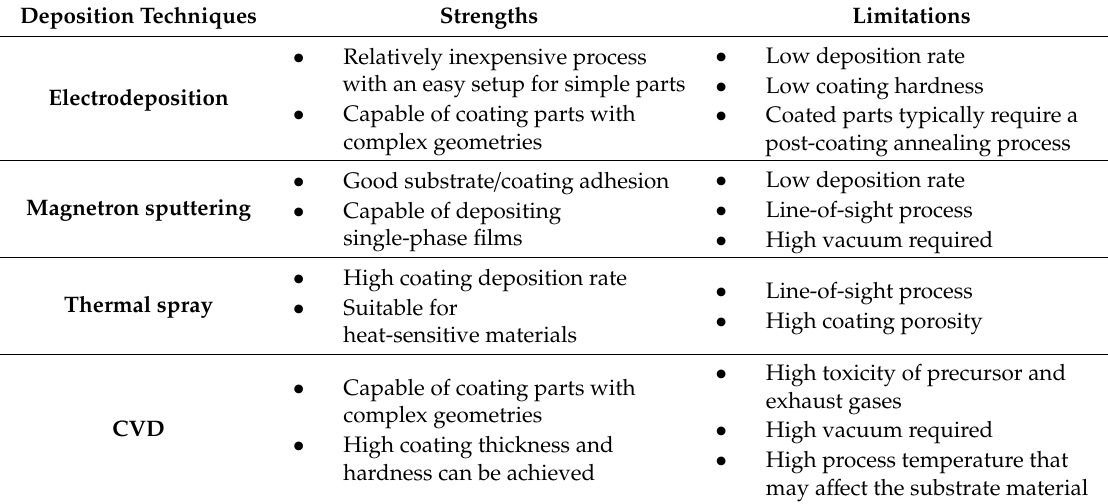
Table 1. Strengths and limitations of coating deposition techniques used to deposit WC-based coatings.